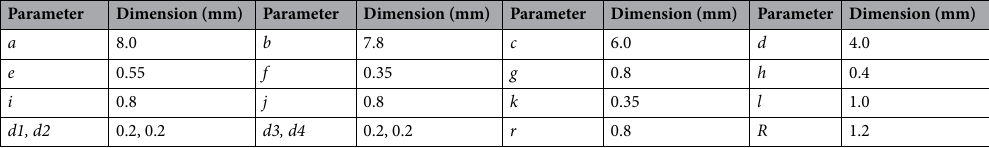
Table 1. Various dimensions of the different segments and split gap of the proposed unit cell.